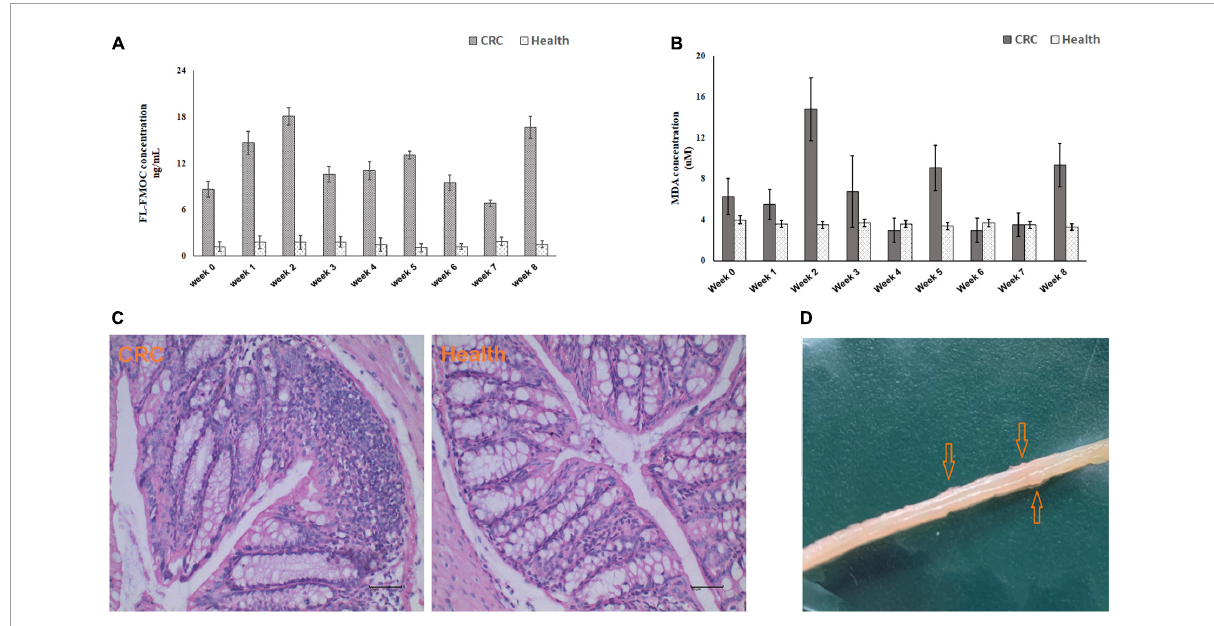
FIGURE2 Biochemical testing of established mouse colorectal cancer model. Inflammation level detected by LC-MS/MS (A) and MDA Assay Kit (B) in control and experimental mice from week 0 to week 8. (C) HE staining of colorectal tissue in control (left) and experiment (right) group. (D) Macroscopic colorectal tumors in experimental mice.